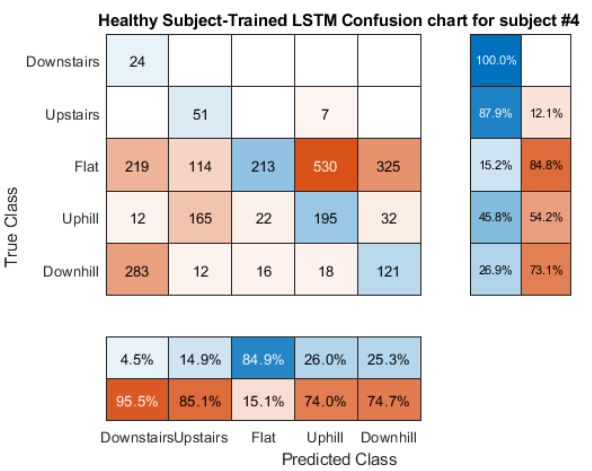
Figure A17. Long Short-Term Memory Network Confusion Chart for ILLA participant A3 as trained by healthy individuals.